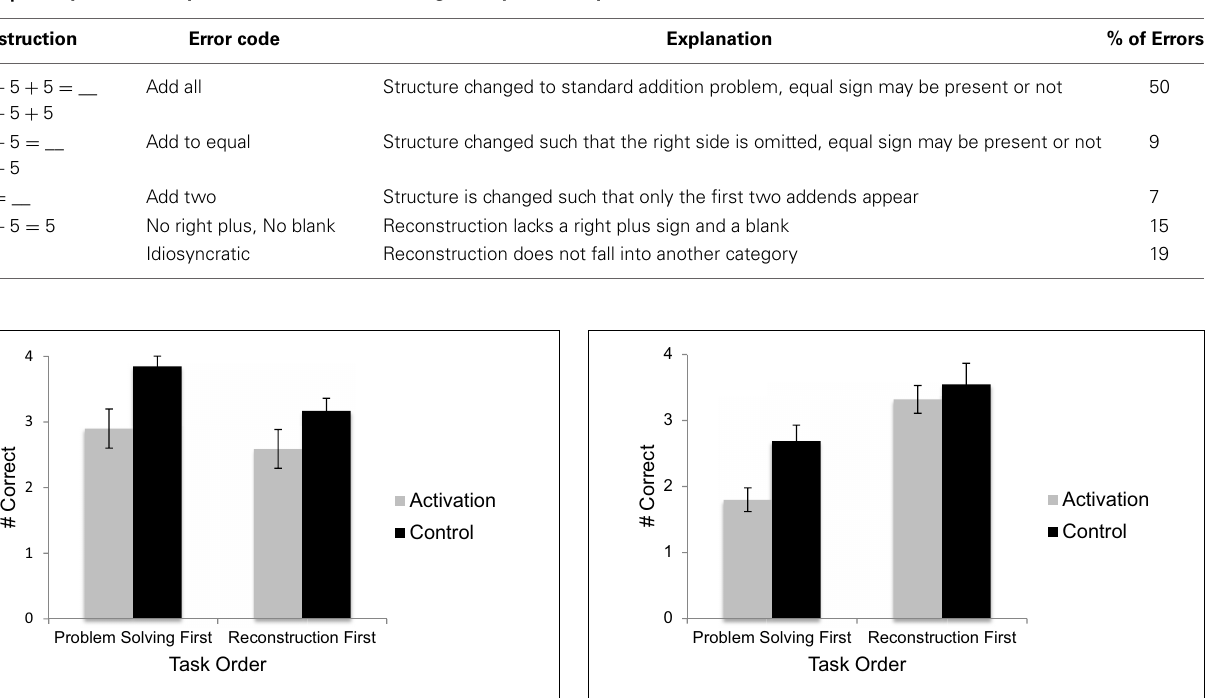
FIGURE 2 | Performance on the problem solving task by task order and condition. Error bars represent ± 1 standard error.